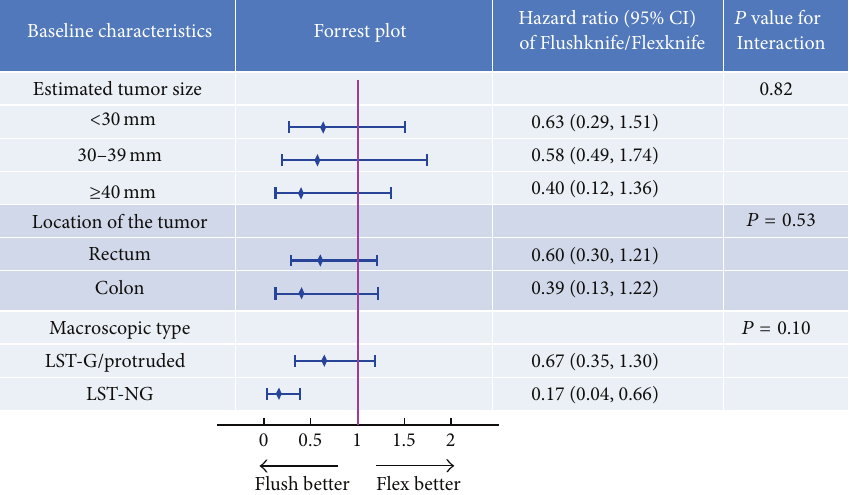
Figure 4: Hazard ratios for completion of the procedure and 95% CIs in each